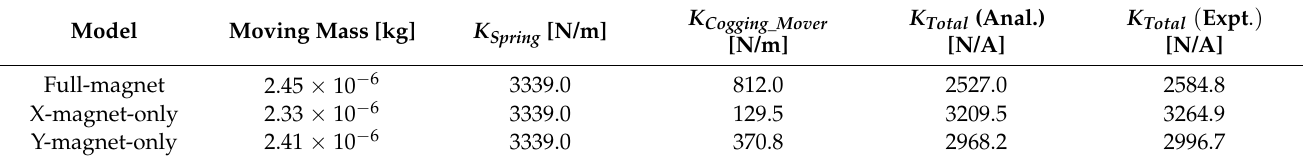
Table 2. Comparison of stiffness values of full-magnet, X-magnet-only, and Y-magnet-only models.